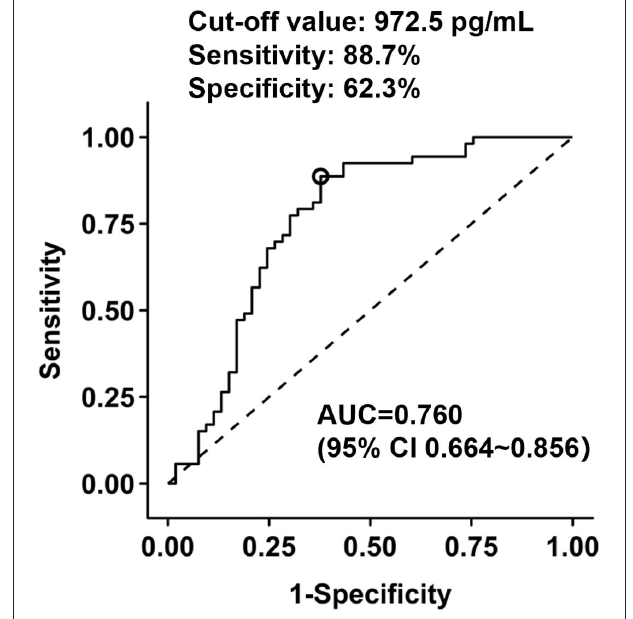
FIGURE 3 | Receiver operating characteristic (ROC) analysis of chromogranin B levels in prediction of LV functional recovery after CTO recanalization.